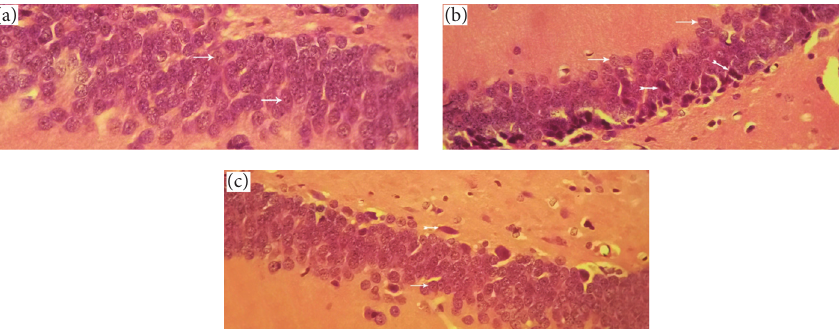
Figure 6: Histopathological assessment. (a) Control group neurons have an integrity and regular structure with normal morphology, round nuclei, prominent nucleolus, and clear cytoplasm. (b) Ischemia group neurons have numerous pyramidal cells with pyknotic nuclei and lack of nucleolus and hyperchromatic cytoplasm. (c) Treatment group have considerably decreased numbers of cells with pyknotic nuclei and lack of nucleolus and hyperchromatic cytoplasm compared to the ischemia group (thin arrows indicate normal cells and thick arrows indicate apoptotic cells).